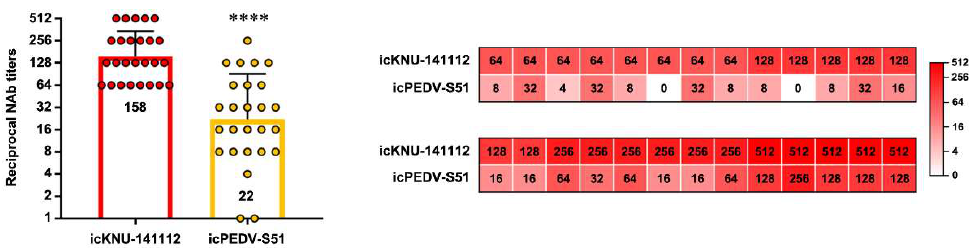
Figure 7. Cross-neutralization between icKNU-141112 and icPEDV-S51. Antiserum samples were subjected to VNT using icKNU-141112 and icPEDV-S51. NAb titers against icKNU-141112 and icPEDV-S51 are graphed as geometric mean titers (GMT) with geometric standard errors. The numbers within the bars show the GMT in the group. Values are representative of the mean from three independent experiments performed in duplicate, and the error bars denote the SDM. **** p < 0.0001. Individual NAb titers in each antiserum against icKNU-141112 and icPEDV-S51 are presented with a heat map on the right. The rainbow color from white to red corresponds to the NAb titer from low to high, respectively. The numbers within the map indicate the reciprocal NAb titers.